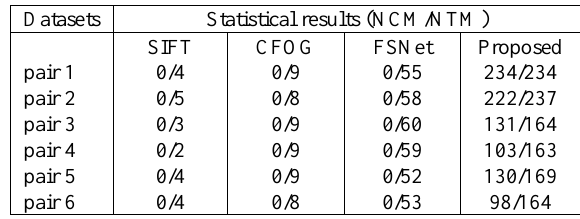
Table 1. Statistical matching results of the proposed method